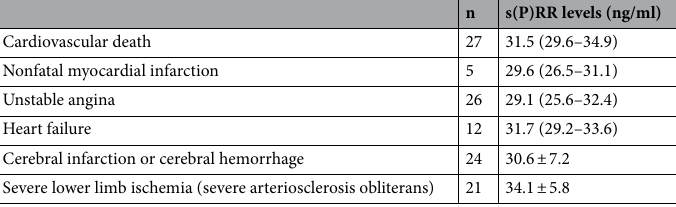
Table 2. Average of serum s(P)RR levels in patients with each new-onset cardiovascular event. s(P)RR, soluble (pro)renin receptor.